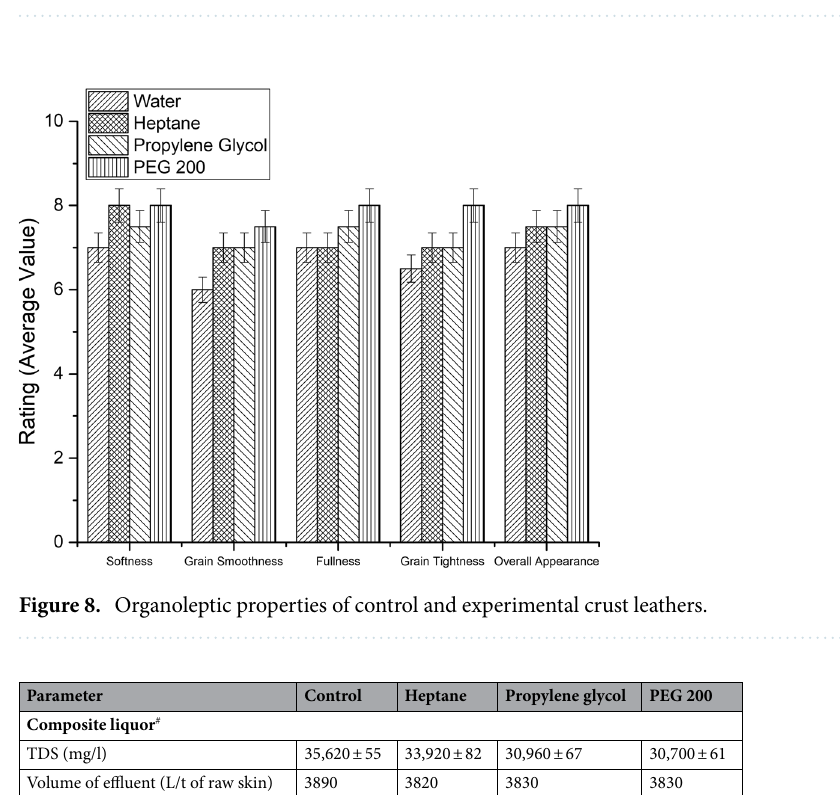
Table 1. Physical properties of control and experimental leathers.